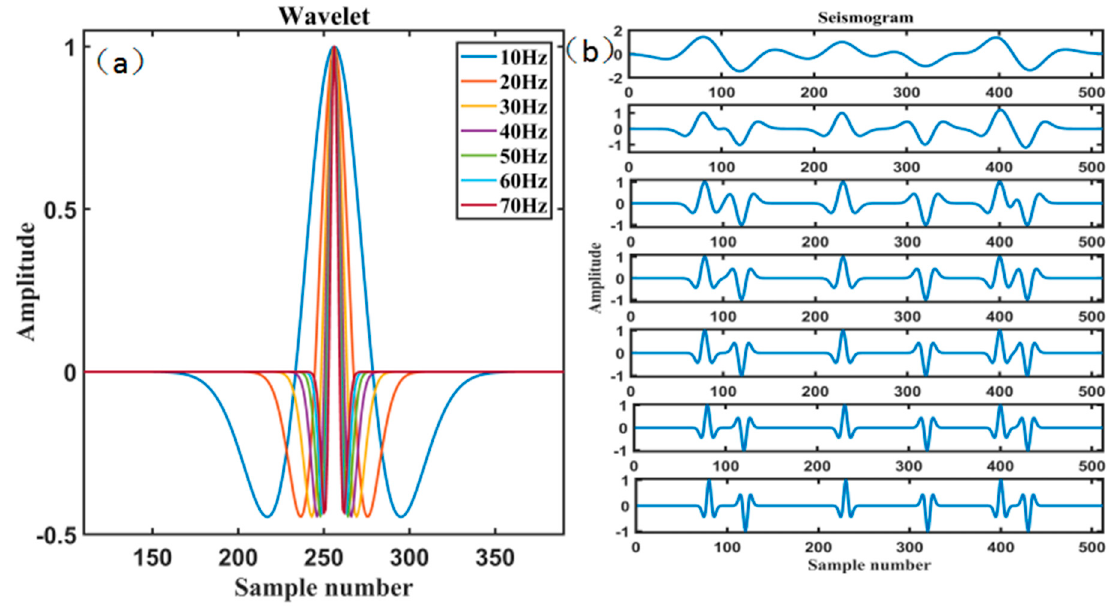
Figure 7. Training seismic data: ( a ) Ricker wavelets of different frequencies (10 Hz, 20 Hz, …, 70 Hz); ( b ) synthetic seismograms.